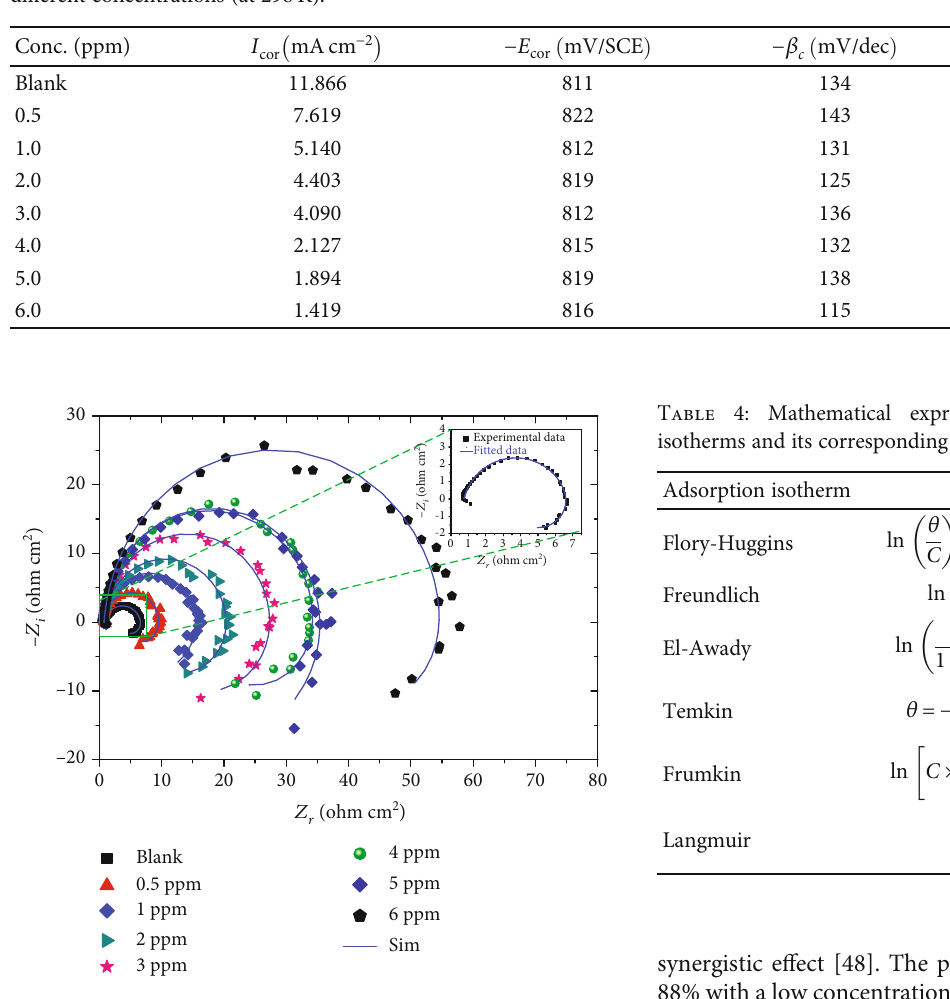
Figure 2: Nyquist plots of AA3003 alloy in 1M HCl solution without and with addition of OMW at di ff erent concentrations (at 298K).